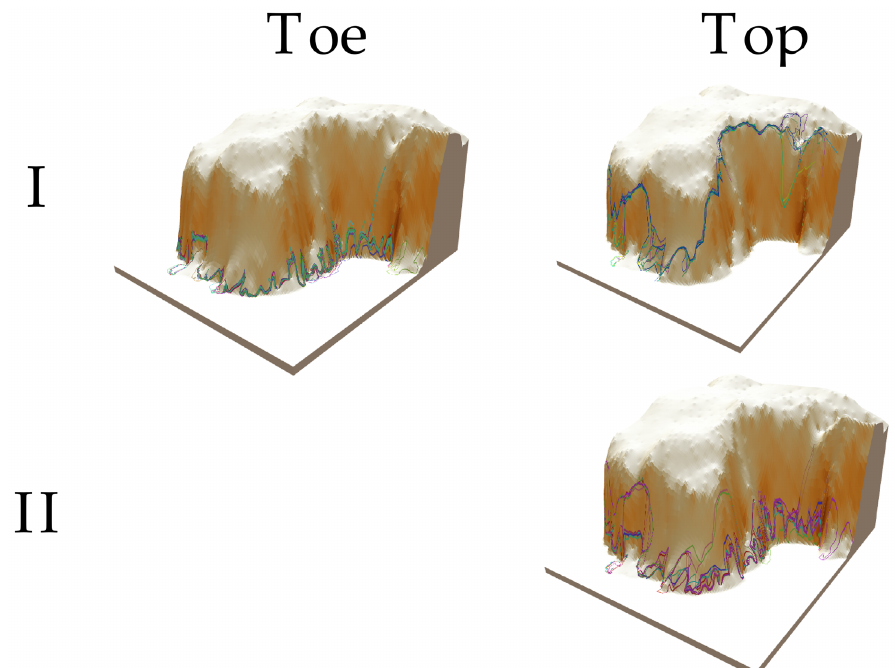
Figure 14. manually digitized cliff top and toe lines (coloured lines) over the DEM for the FH2 site. DEM colours represent slope (darker colours represent higher slopes). The vertical dimension has been exaggerated 10 times. The roman numbers represent the main clusters of manually digitized